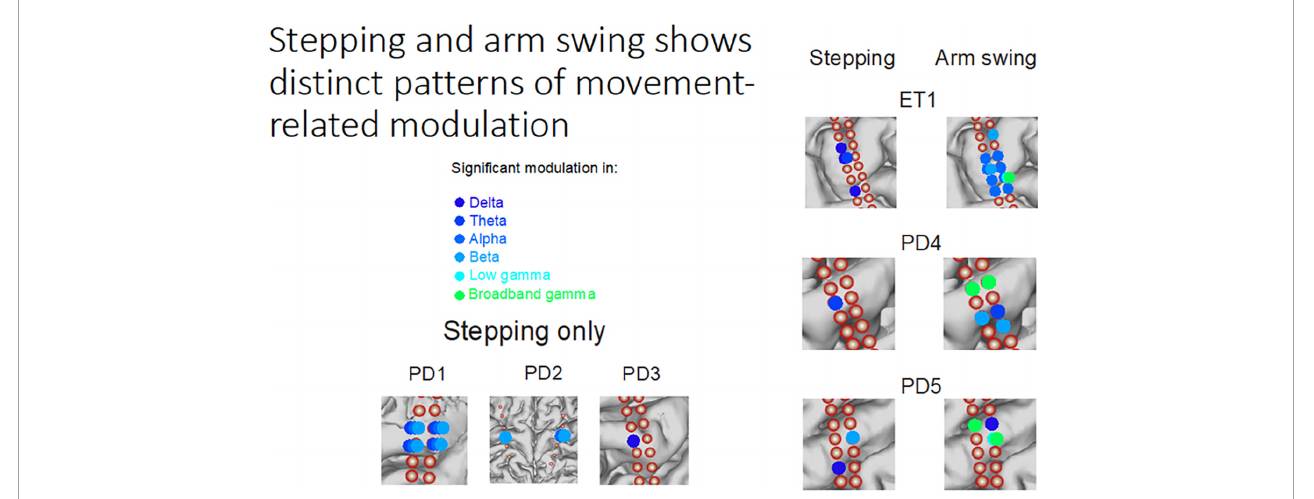
FIGURE2 Stepping and arm swing shows distinct patterns of movement-related modulation–Subdural electrocorticography recordings demonstrate significant modulation of various frequency bands while performing different movement tasks. The modulation is unique from both a neuroanatomical perspective and an electrophysiologic